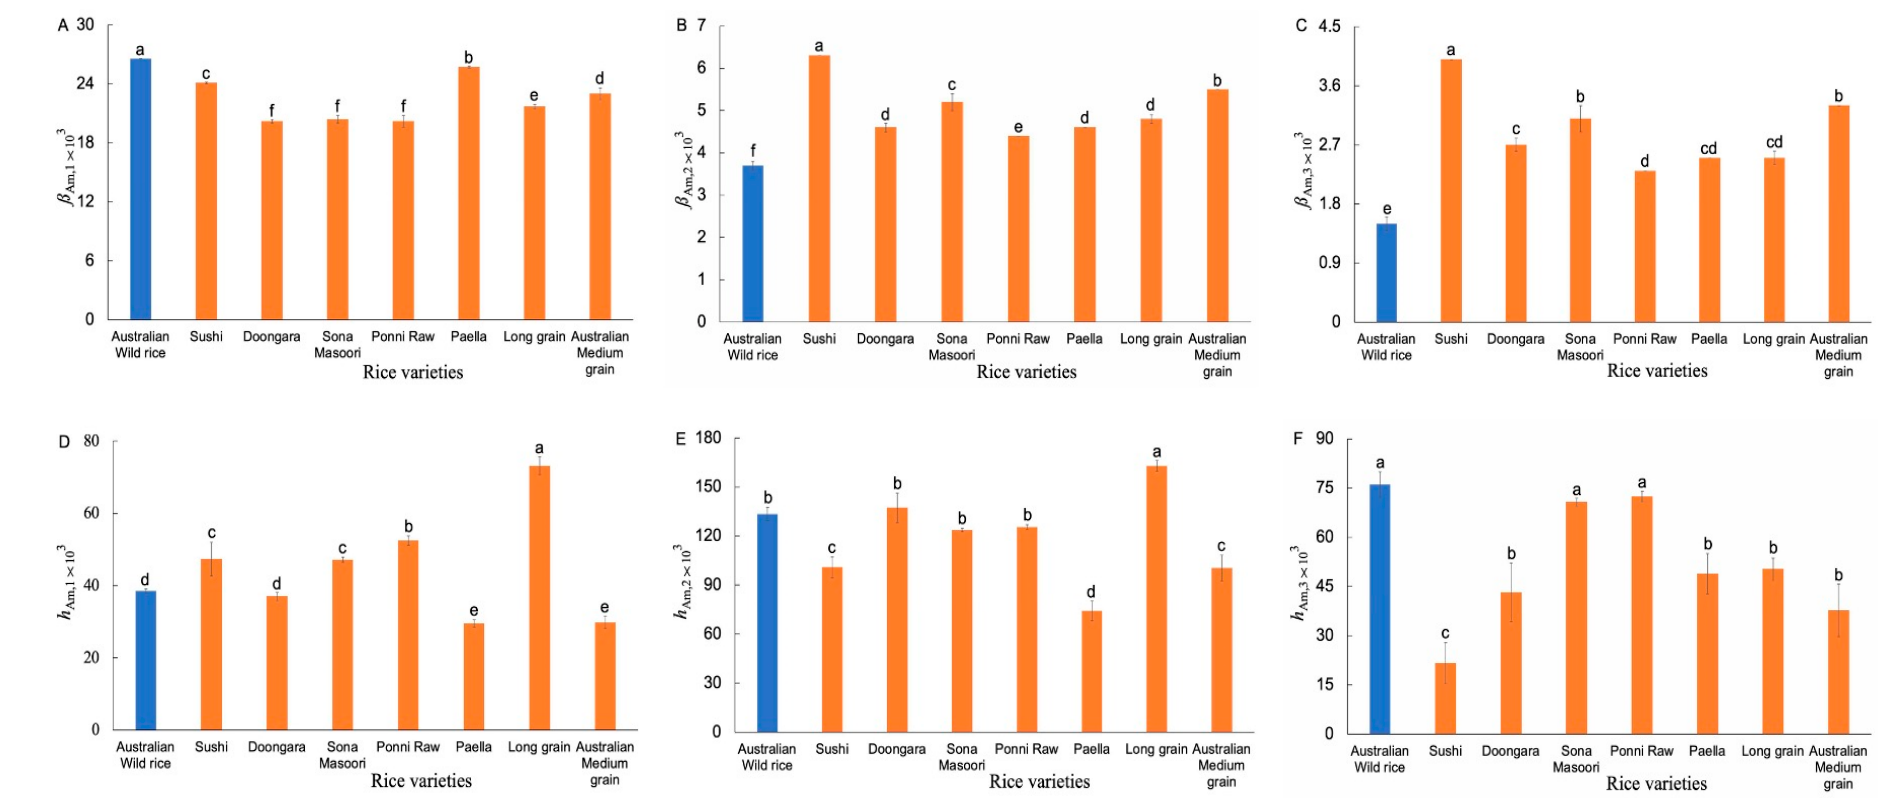
Figure 4. Comparison of Am structural parameters of AWR starch and CR starches ( A – F ). Blue and red: Australian wild and commercial rices, respectively. All data were from duplicate measurements. The same letters mean no significant difference ( p < 0.05).